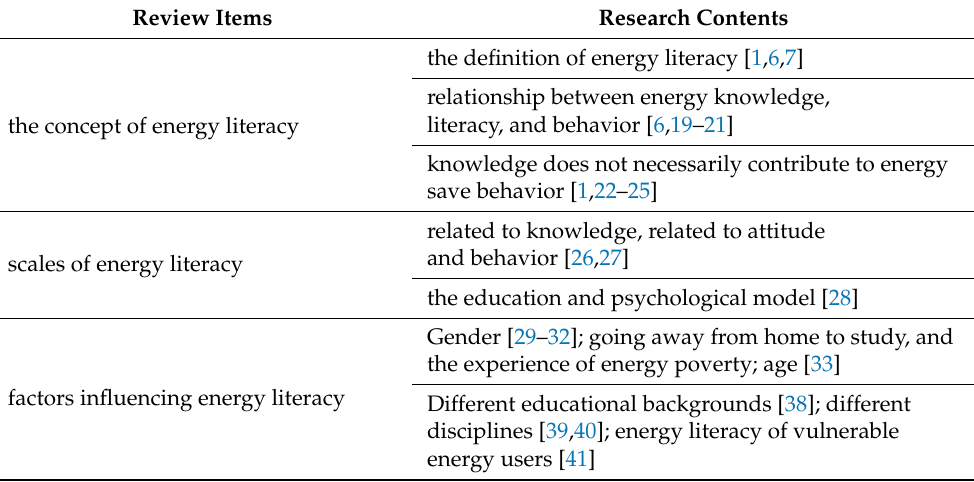
Table 1. The development of energy literacy review (Source: by own